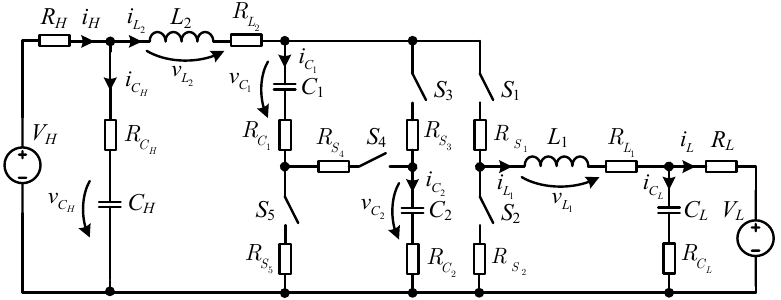
Figure 14. BHSC schematic with parasitic components, used for stability analysis.